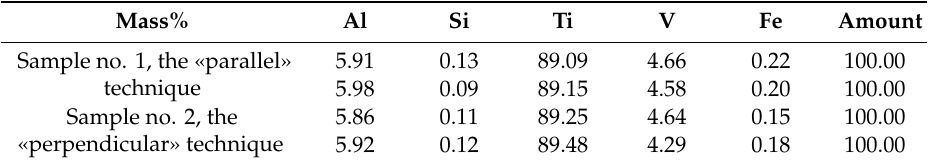
Table 1. Results of samples chemical analysis.